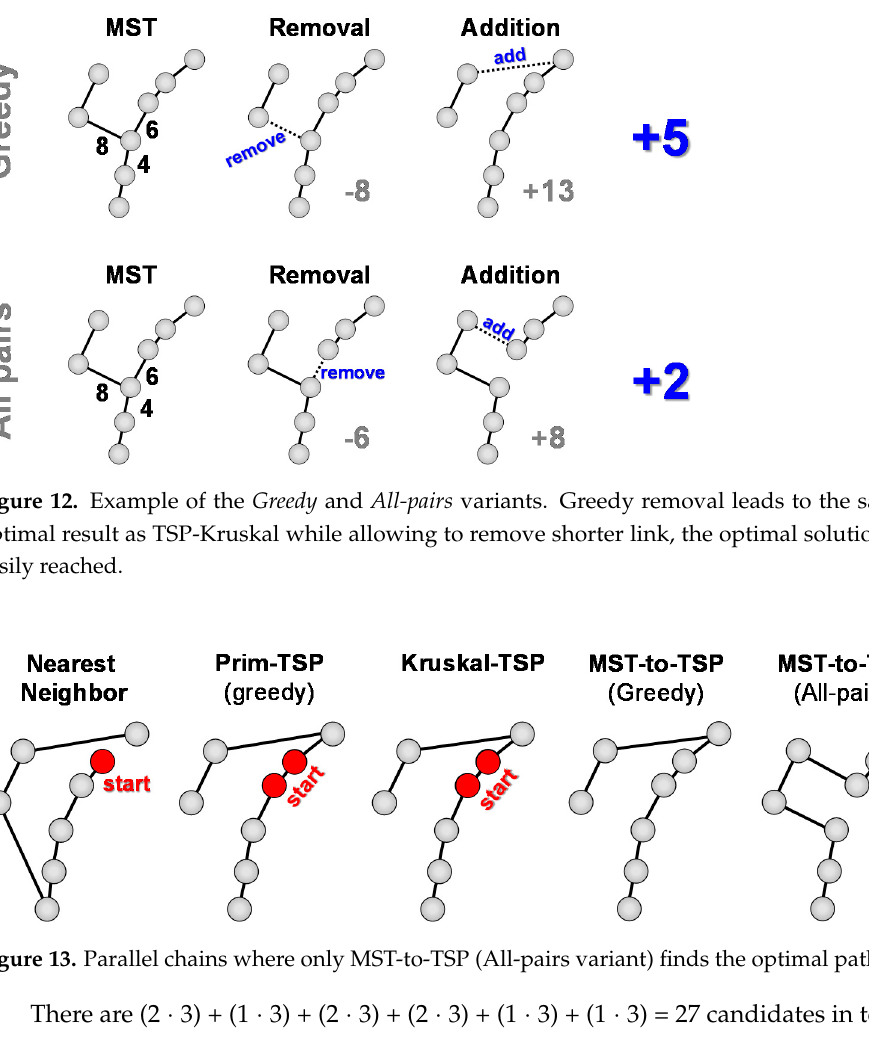
Figure 11. Results of the various algorithms for the toy example.